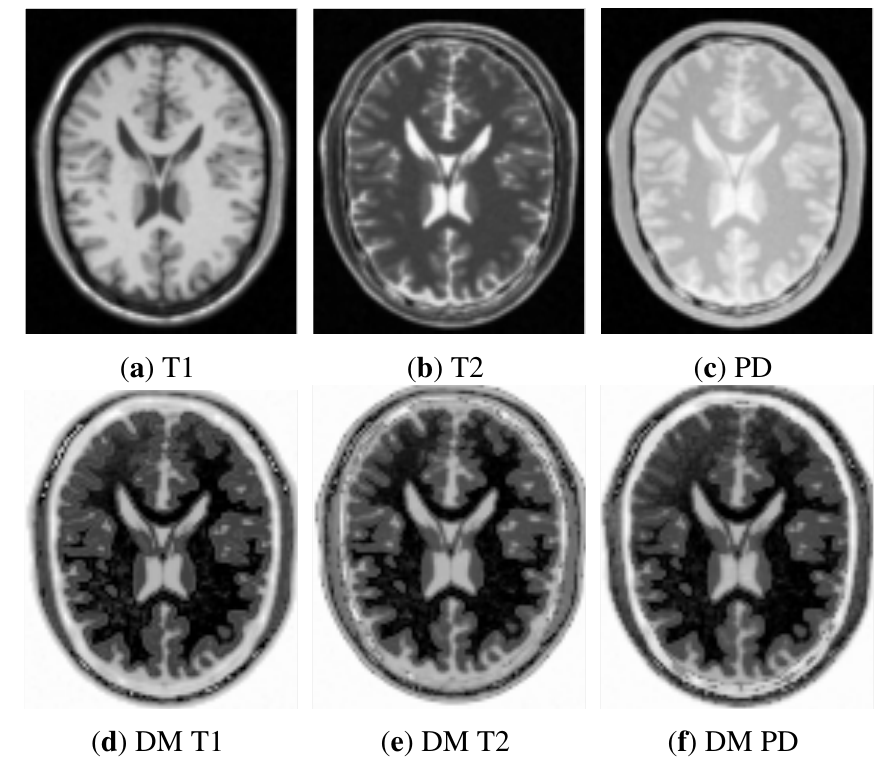
Figure 3. Example of multimodal images from BrainWeb data set ( top row ) and their corresponding diffusion-map images ( bottom row ).